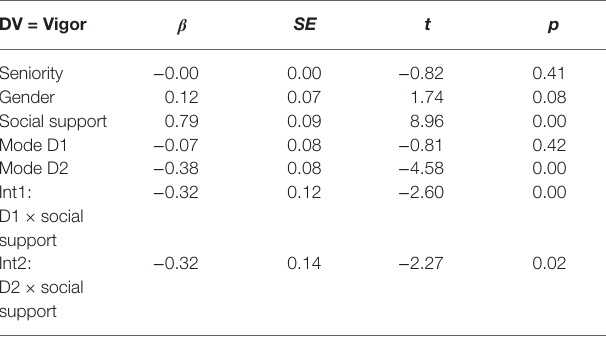
TABLE 3 | Regression analysis testing the effects of the interaction between levels of social support and the modality of work in the explanation of levels of